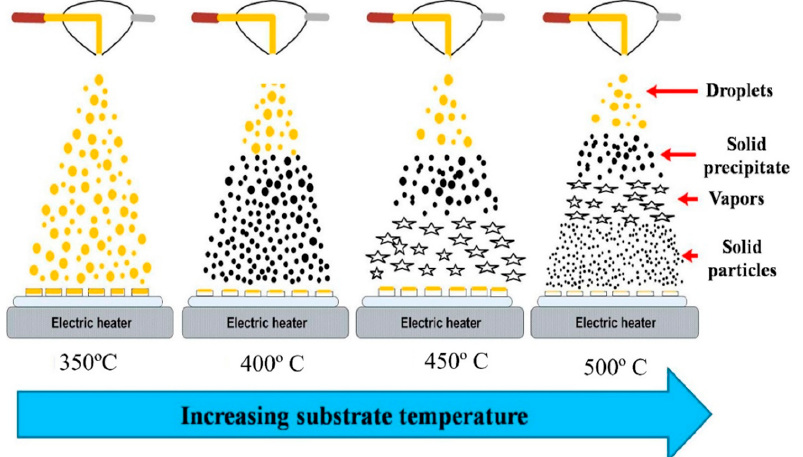
Figure 6. Deposition of V 2 O 5 thin films at different substrate temperatures[2].